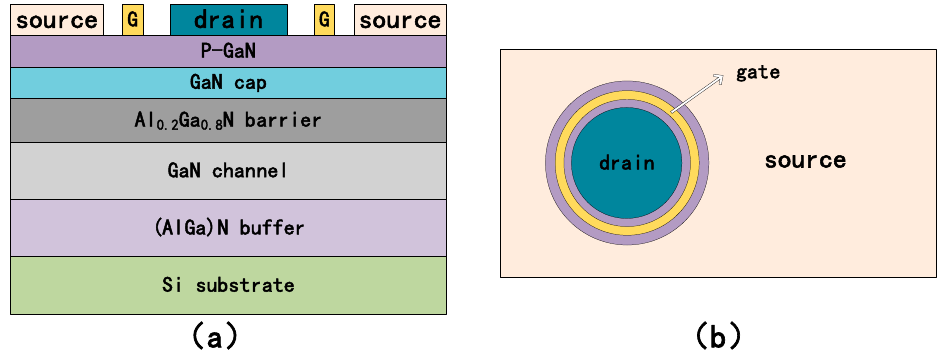
Figure 1. ( a ) Cross-sectional view and ( b ) top view of ring-gate AlGaN/GaN HEMT device.